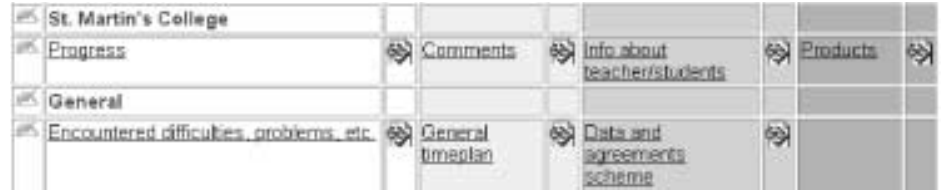
Figure 1. Example of a Roster with activities that are not related to a specific time. Some are only visible for a subset of students (in this case, ‘St Martin’s College’) while others are seen by all